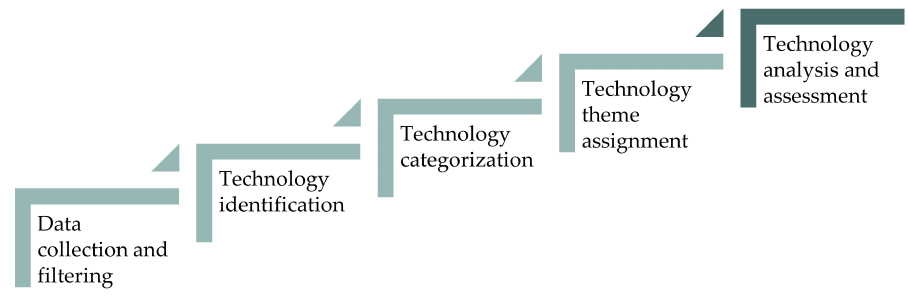
Figure 1. Technology assessment methodological steps (adapted from